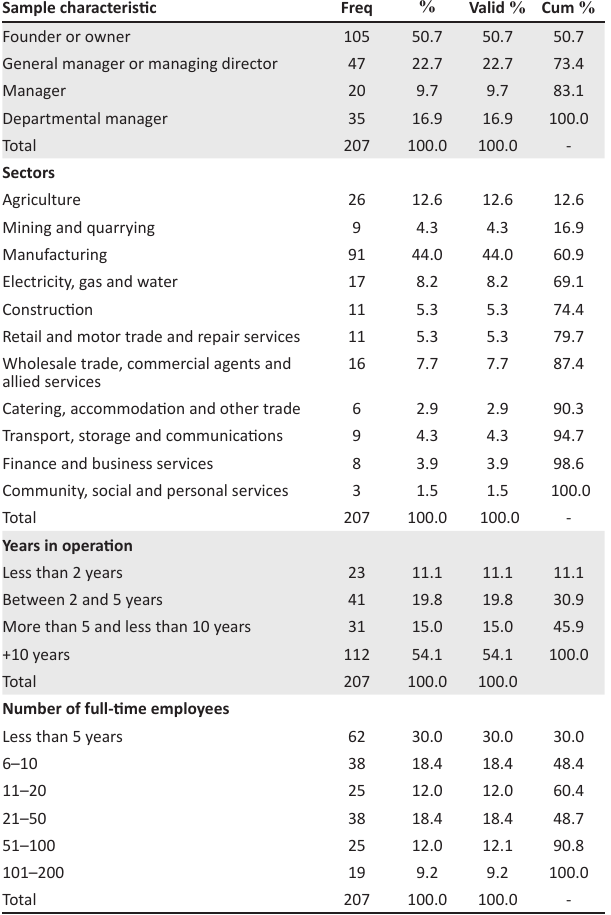
TABLE 1: Sample profile. Sample characteristic